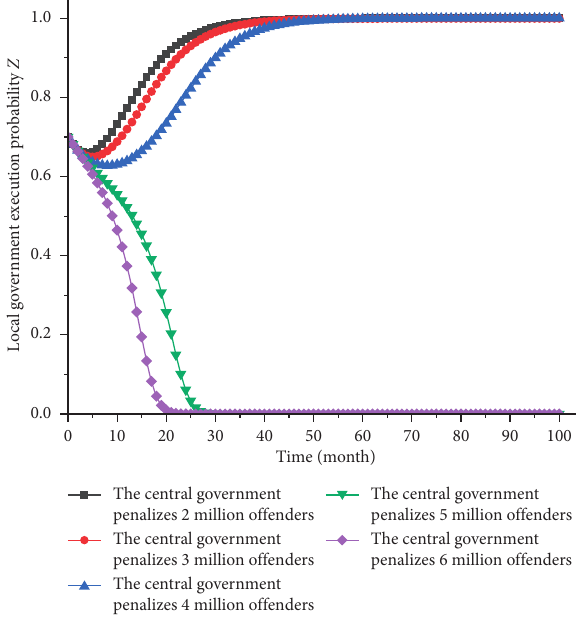
Figure 11: Impact of central fines on strategic choices of local governments.